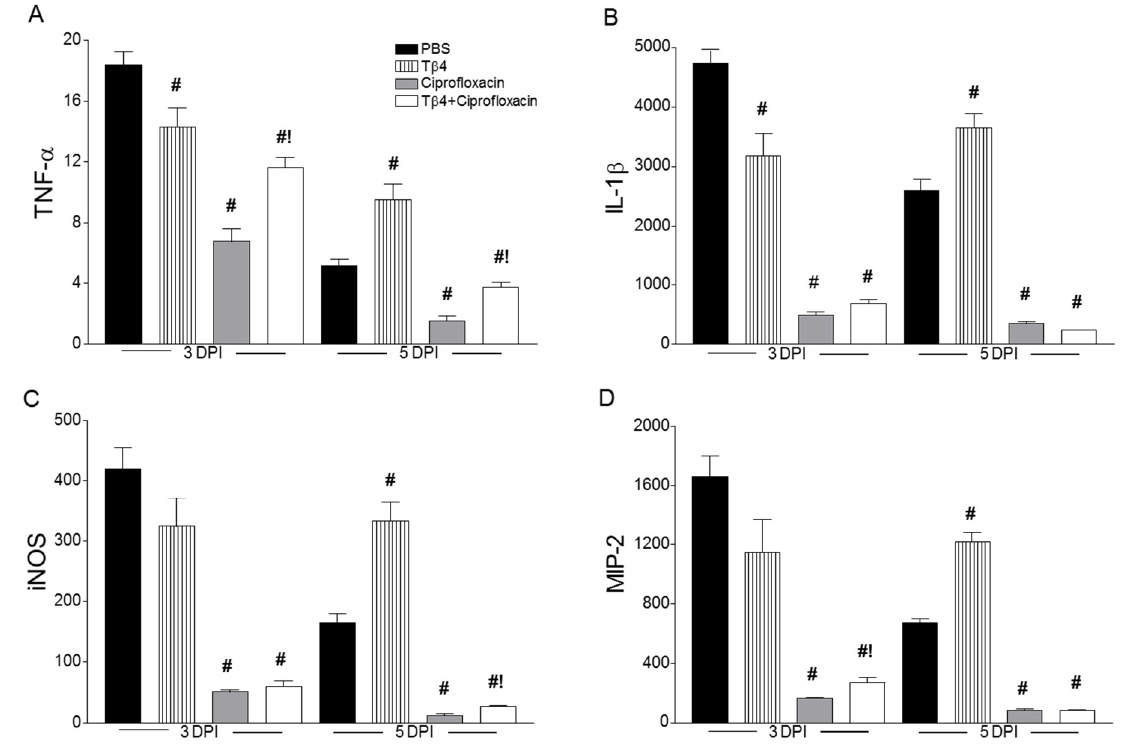
Figure 4. mRNA levels of select cytokine and chemokines at 3 and 5 days p.i. in corneas of B6 mice after PBS, Tβ4, ciprofloxacin, and Tβ4 + ciprofloxacin treatment. mRNA expression levels for TNF-α ( A ), IL-1β ( B ), iNOS ( C ), and MIP-2 ( D ) are normalized to β-actin and represented as relative fold change for the gene of interest compared to normal (uninfected) controls ± SEM. N = 8 corneas/group/time point. # P < 0.05 versus PBS; ! P < 0.05 versus ciprofloxacin.